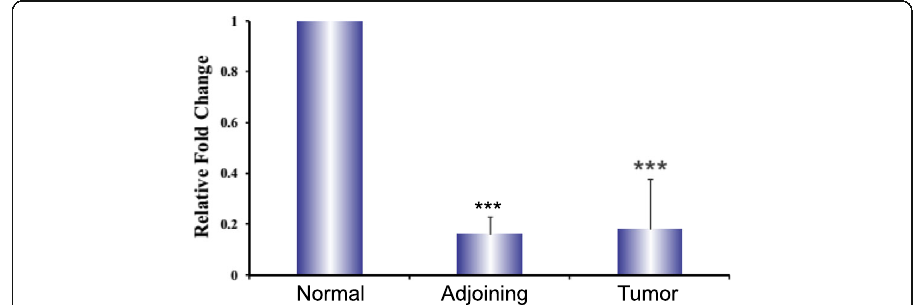
Fig. 2 mRNA expression analysis of TCF-4 gene by qRT PCR. Relative mRNA levels of TCF-4 gene in tumor, adjoining and normal mucosa from CRC Patients. *** p < 0.001 compared to normal